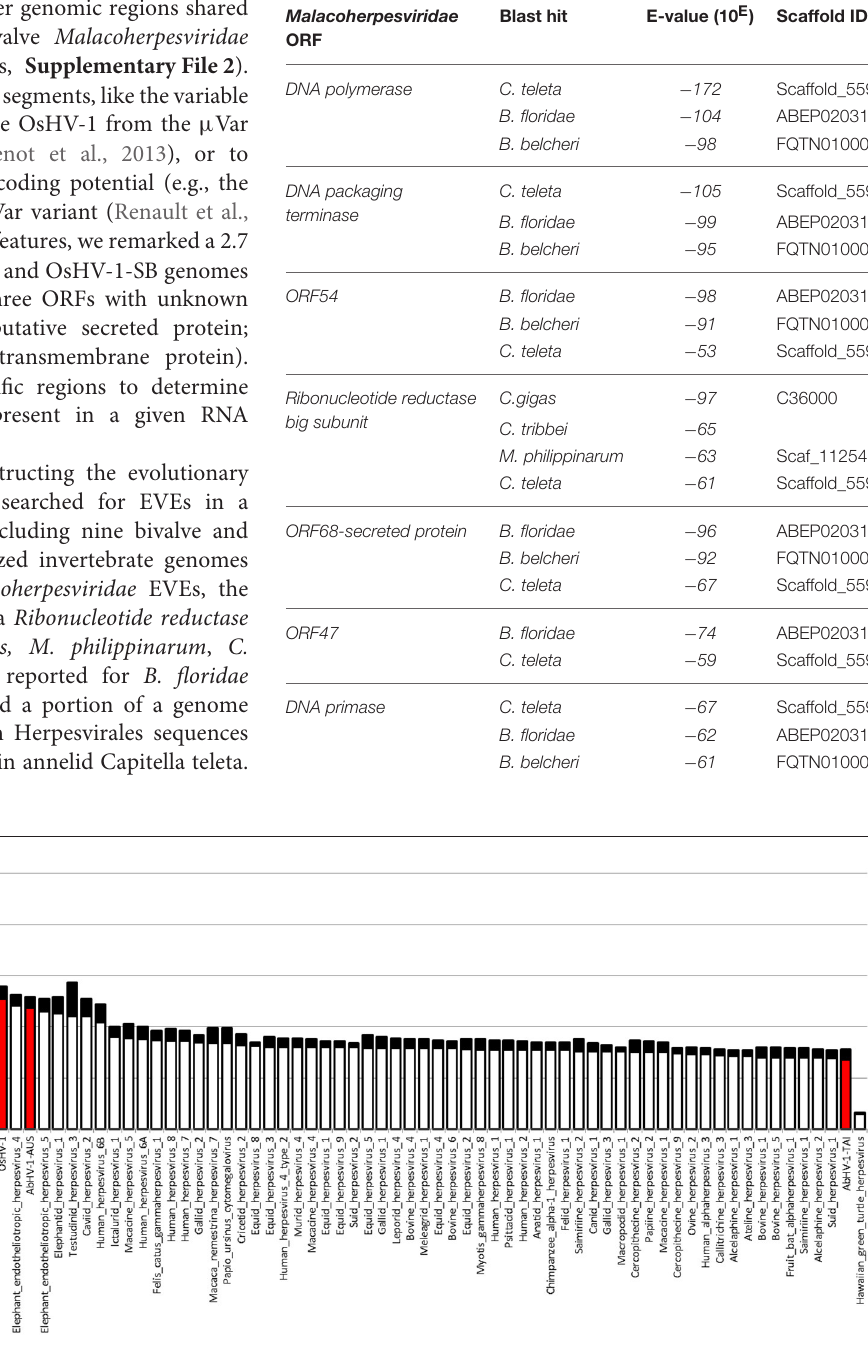
FIGURE 1 | Number of ORFs identified in Herpesvirales genomes. The black part of each bar indicates the ORFs fraction with a predicted signal peptide. Malacoherpesviridae genomes are highlighted by the red bars.